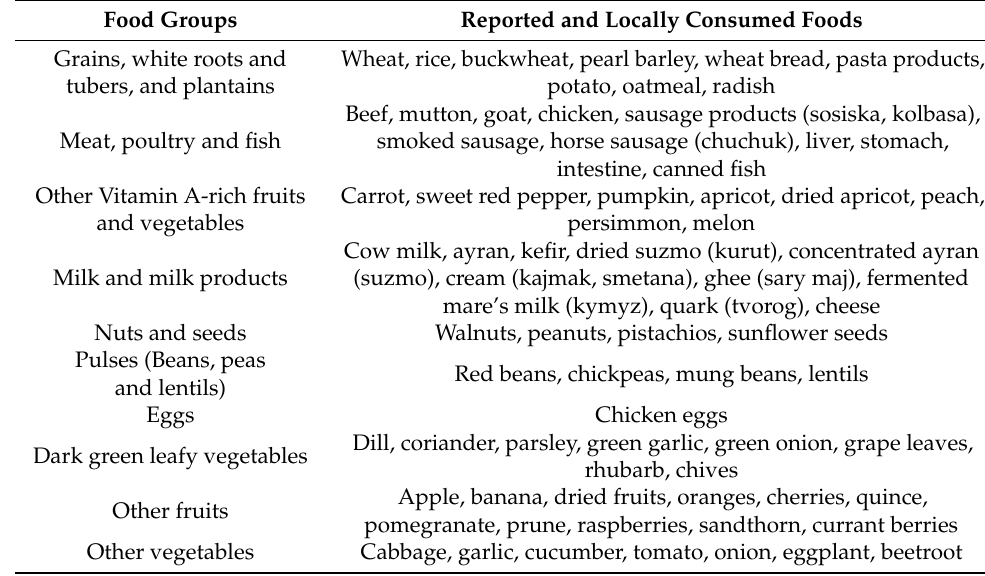
Table 3. Food groups and locally consumed foods obtained from 24-hour diet